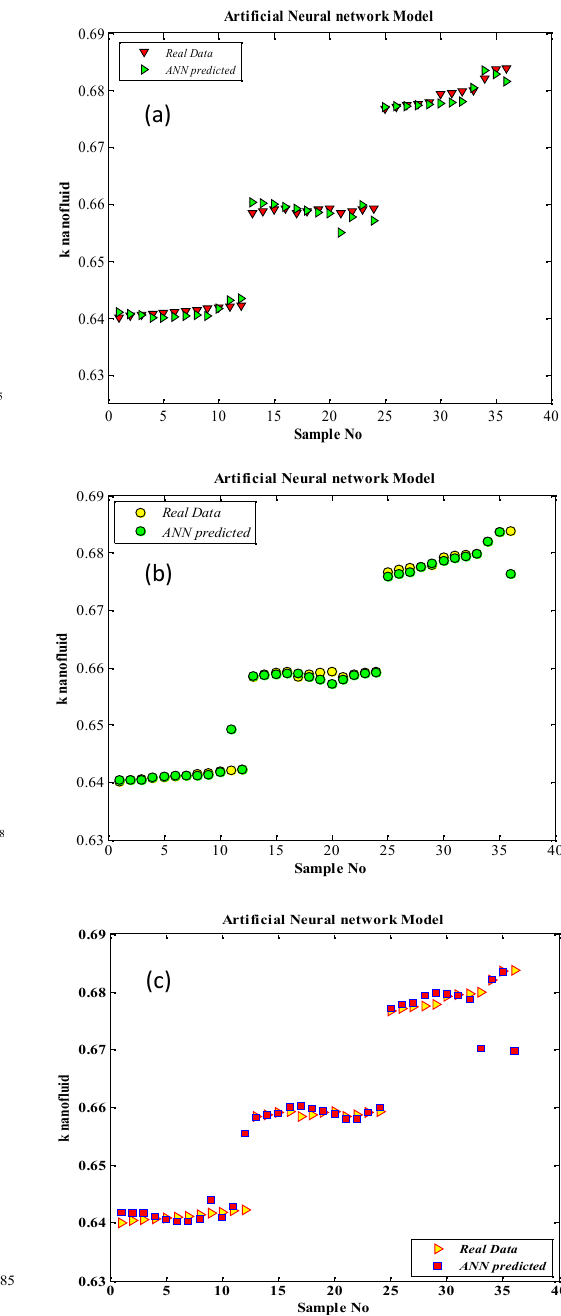
Fig. 5: a, b and c): The comparison between experimental results and predicted results obtained by neural network for thermal conductivity with 10, 15 and 20 neurons, respectively ( x (Target): experimental results and y (Output): predicted results). Fig. 6: The comparison between experimental results and predicted results obtained by neural network for thermal conductivity with 10, 15 and 20 neurons, respectively ( x : the tested samples, y: thermal conductivity ratios of nanofluid)